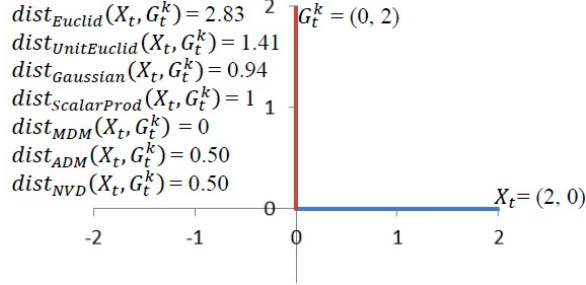
Figure 4: Distance values computed using different metrics (Equa- tions 15, 16, 18, 20, 22, 23,